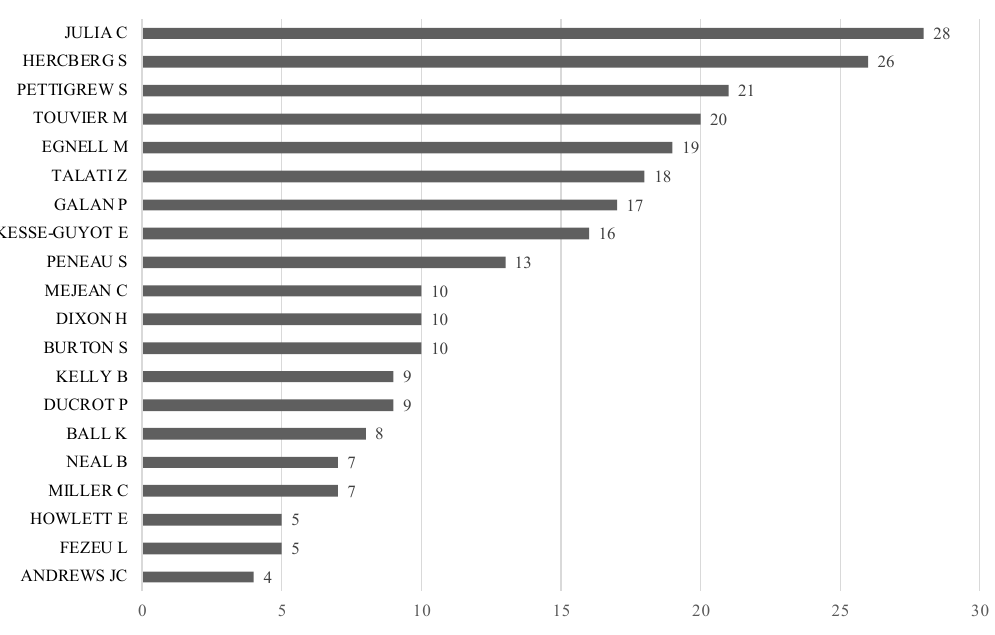
Figure 7. The most-cited articles. The most prolific countries are the USA, with 194 documents and 1115 citations, France, with 155 documents and 658 citations, and Australia, with 127 documents and 371 citations. Similarly, the most collaborative countries are the USA, France and Australia (Table 3). Table 3. Most prolific countries and the number of citations. Country Frequency